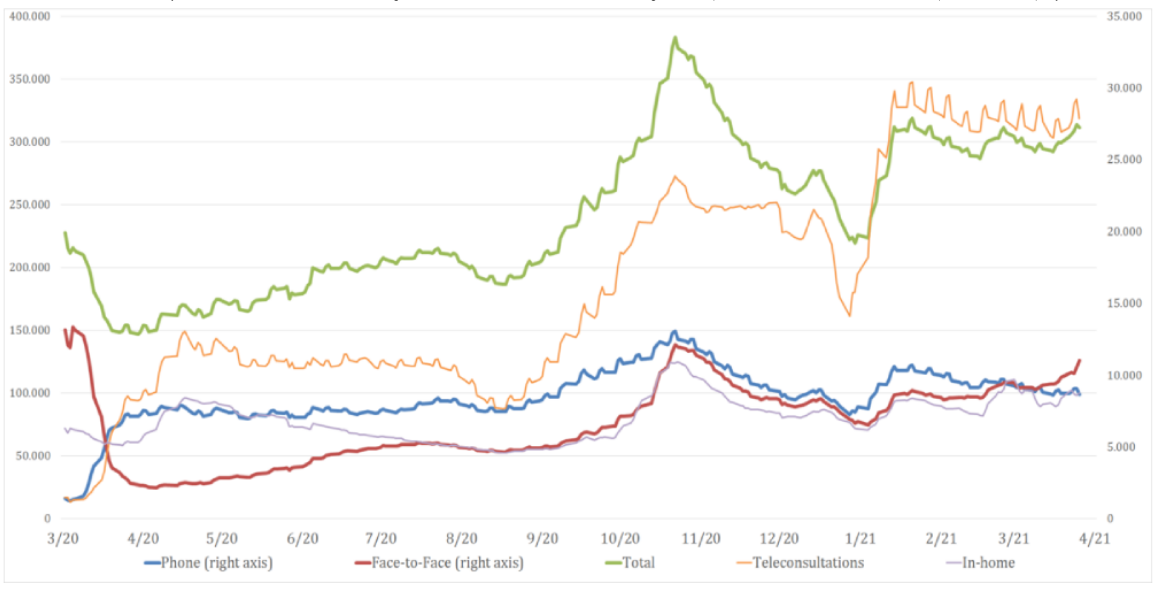
Figure 1. Primary care daily visits in the Catalonia region of Spain, classified by type with 7-day moving average excluding weekends and